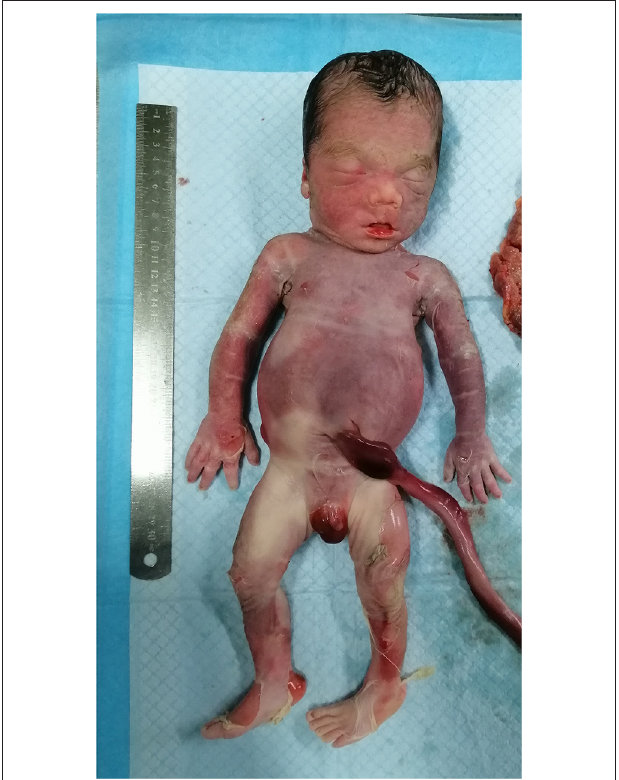
FIGURE 3 | Photograph of the induced fetus.